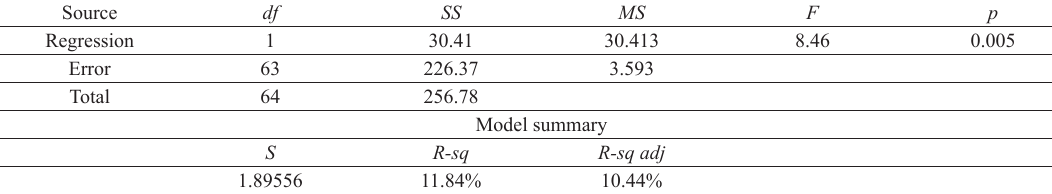
Table 10. Analysis of Variance: 45-A Orientation Tension Strength versus Density.